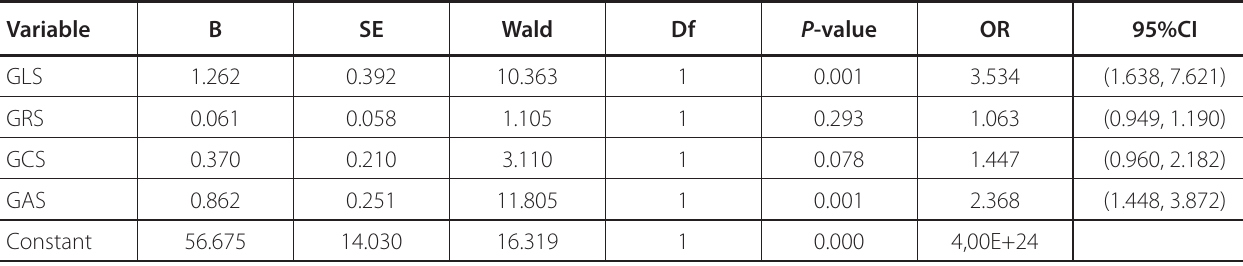
Table 5 . Univariate logistic regression analysis of the factors possibly associated with CMD.